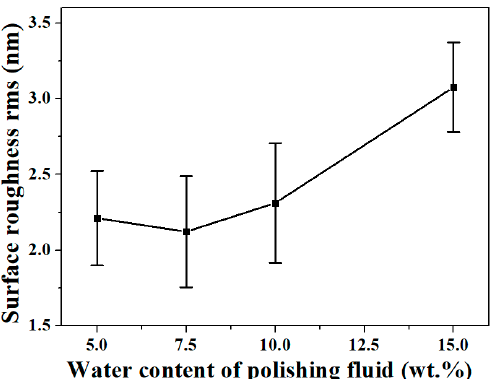
Figure 3. Variations in surface roughness with water content of polishing fluid (the data used to plot this curve are from [21]).